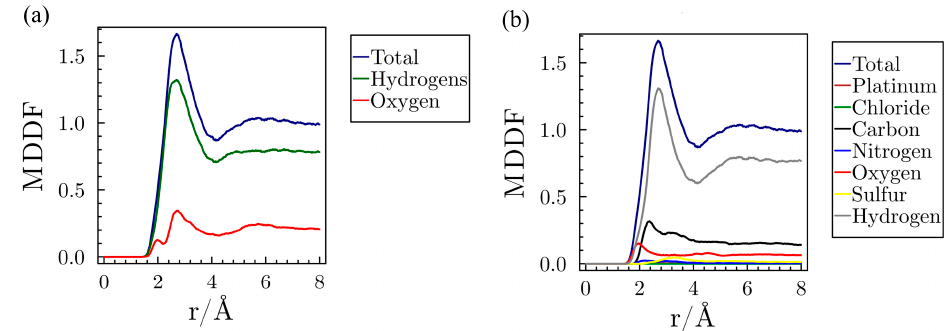
Figure 7. Minimum Distance Distribution Function of water with respect to PC. ( a ) Contribution of O (red) and H (green) atoms to the total function (blue). ( b ) Contribution of the PC atoms to the total function (blue).